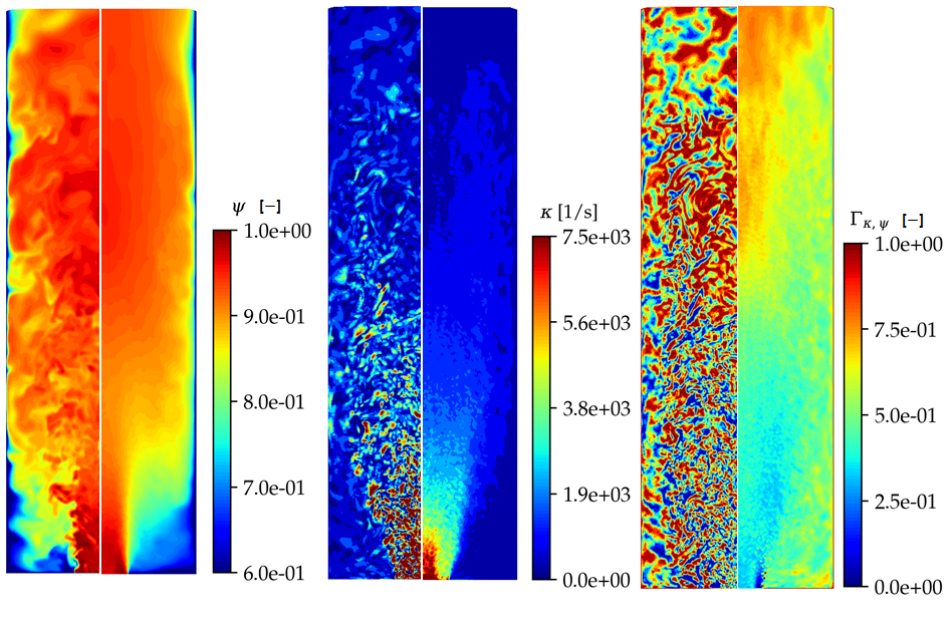
Figure 12. Contour maps of instantaneous and mean field for heat loss Ψ , stretch κ , and correction factor Γ κ , Ψ .